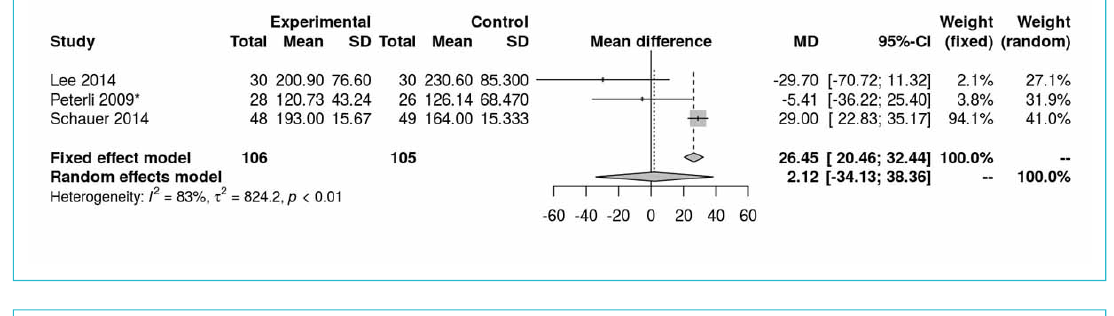
Figure S6d: Fasting blood glucose at baseline without Schauer et al. 2014 [13] (analysis of studies including only patients with type 2 dia-